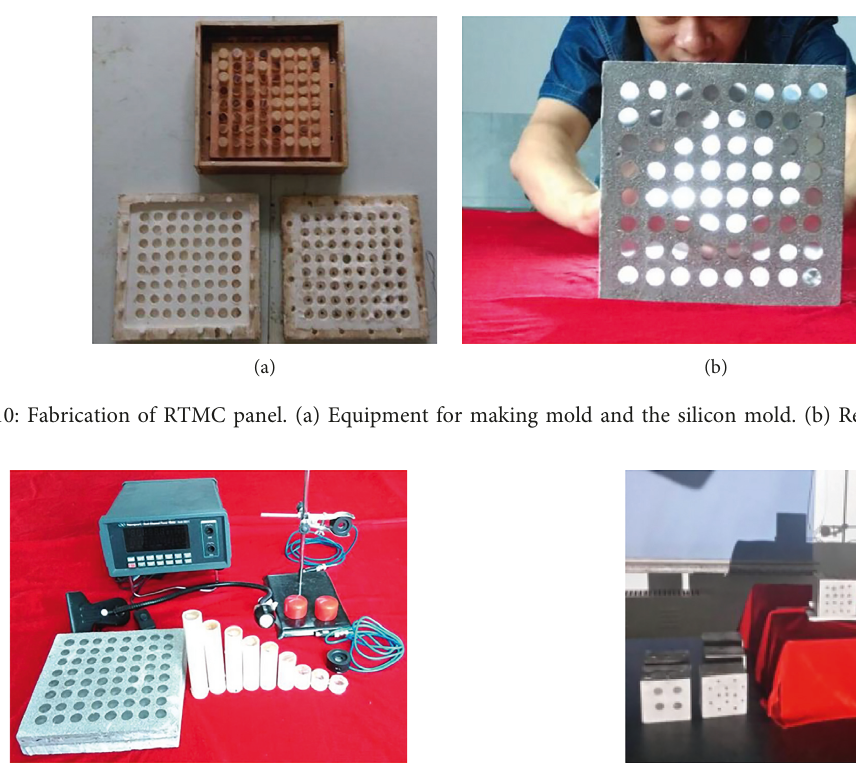
Figure 11: Devices of the transmittance test. Figure 12: Transmittance test of RTMC.